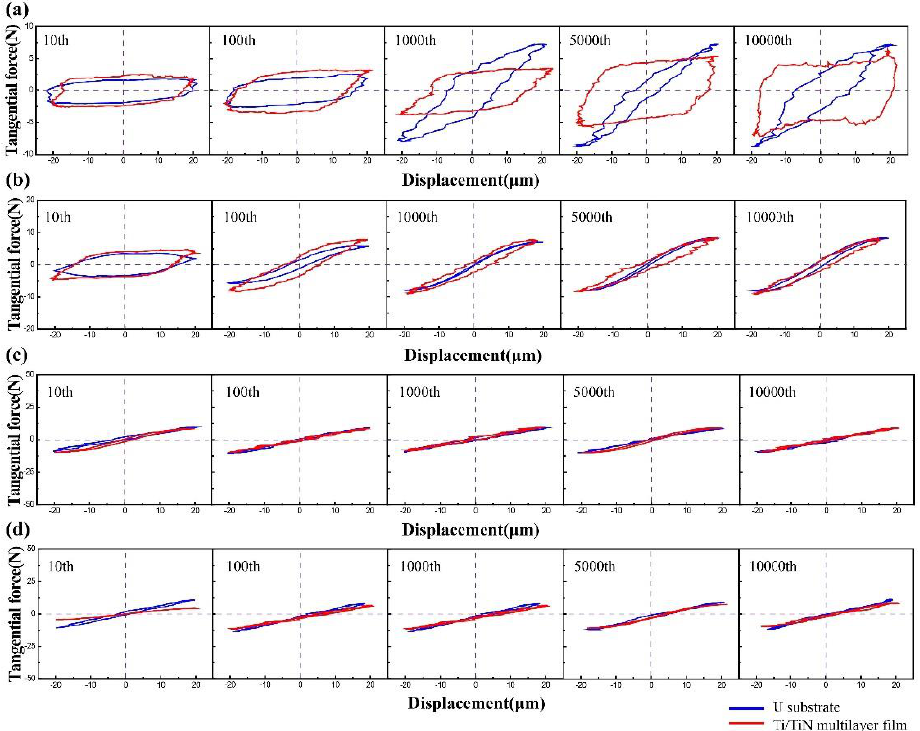
Figure 2. Fretting loops for depleted uranium (DU) and a titanium/titanium nitride (Ti/TiN) film on DU under various normal loads; ( a ) Fn (force of normal loads) = 10 N. ( b ) Fn = 20 N. ( c ) Fn = 50 N. ( d ) Fn = 100 N.